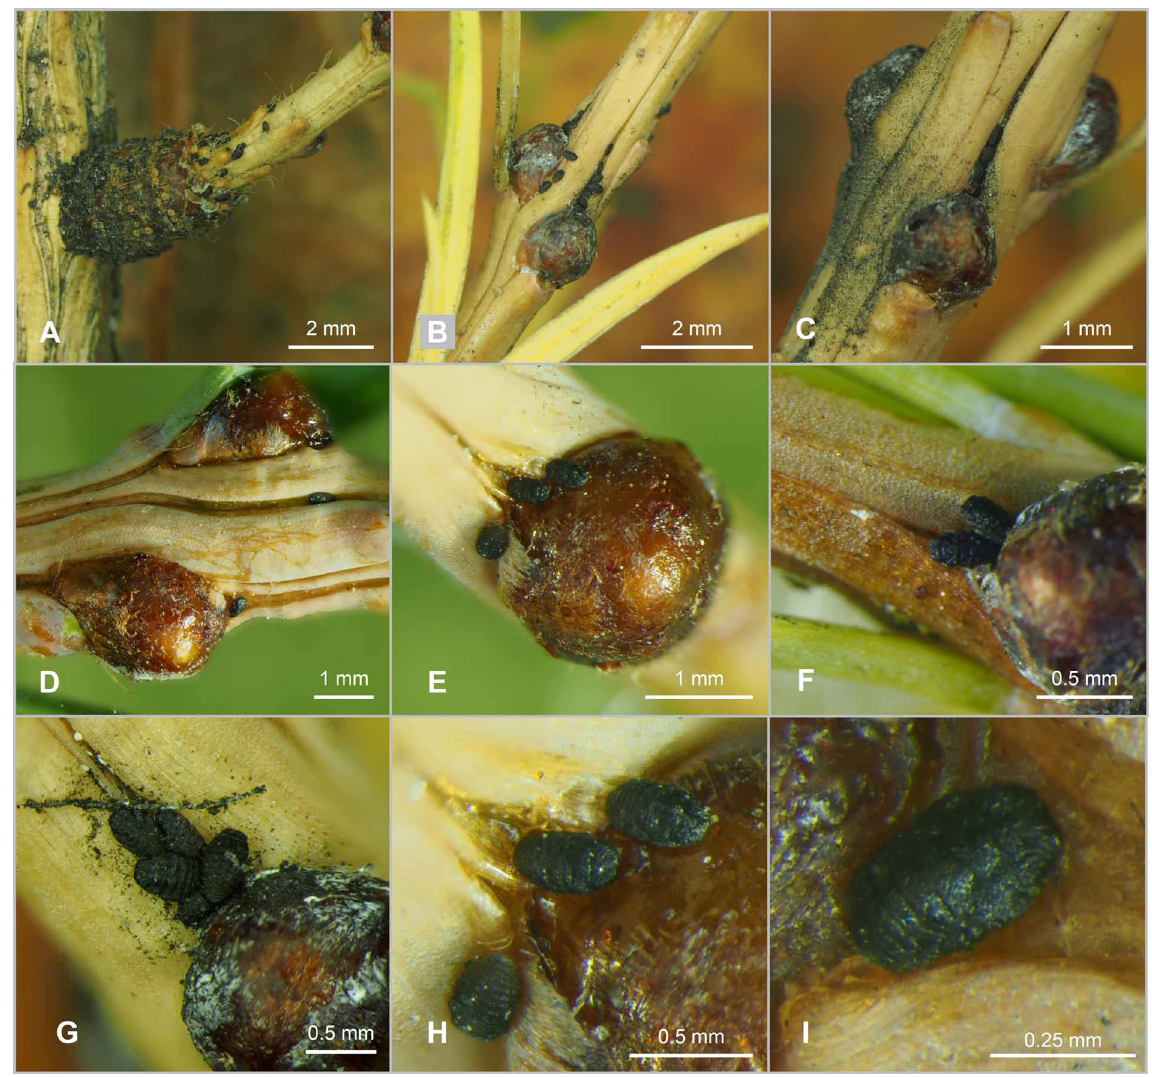
Fig. 58. Adelges (Adelges) laricis Vallot, 1836. Neosistentes in winter on twigs of Larix sibirica